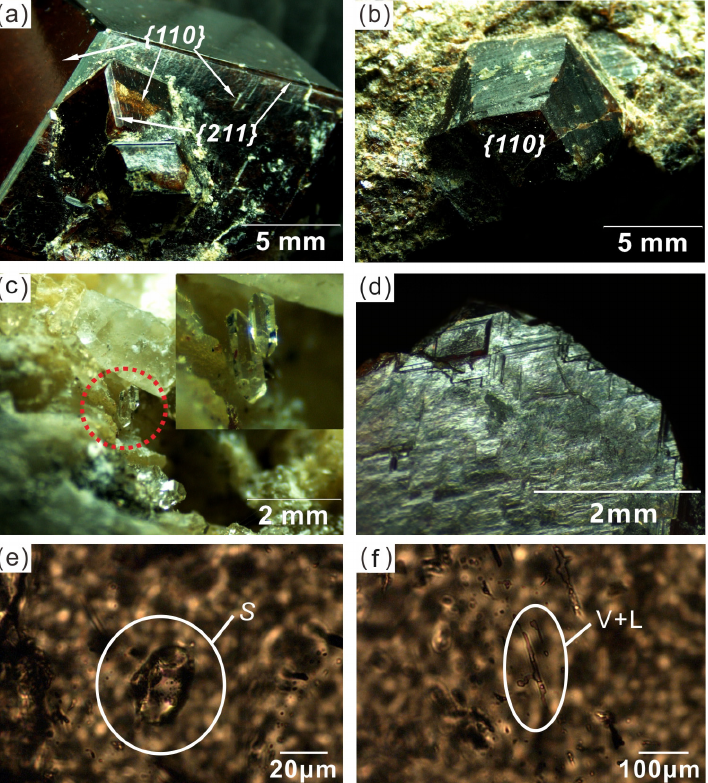
Figure 2. Representative photomicrographs of garnet samples. ( a ) The combination form of garnet bounded by dodecahedral faces {110} and trapezohedron faces {211}; ( b ) Dodecahedral simplex of garnet; ( c ) Quartz crystal around the pore (dashed line); ( d ) Crystal patterns on dodecahedral face under gem microscope; ( e , f ) The solid inclusion and gas–liquid inclusion (solid line) under Raman